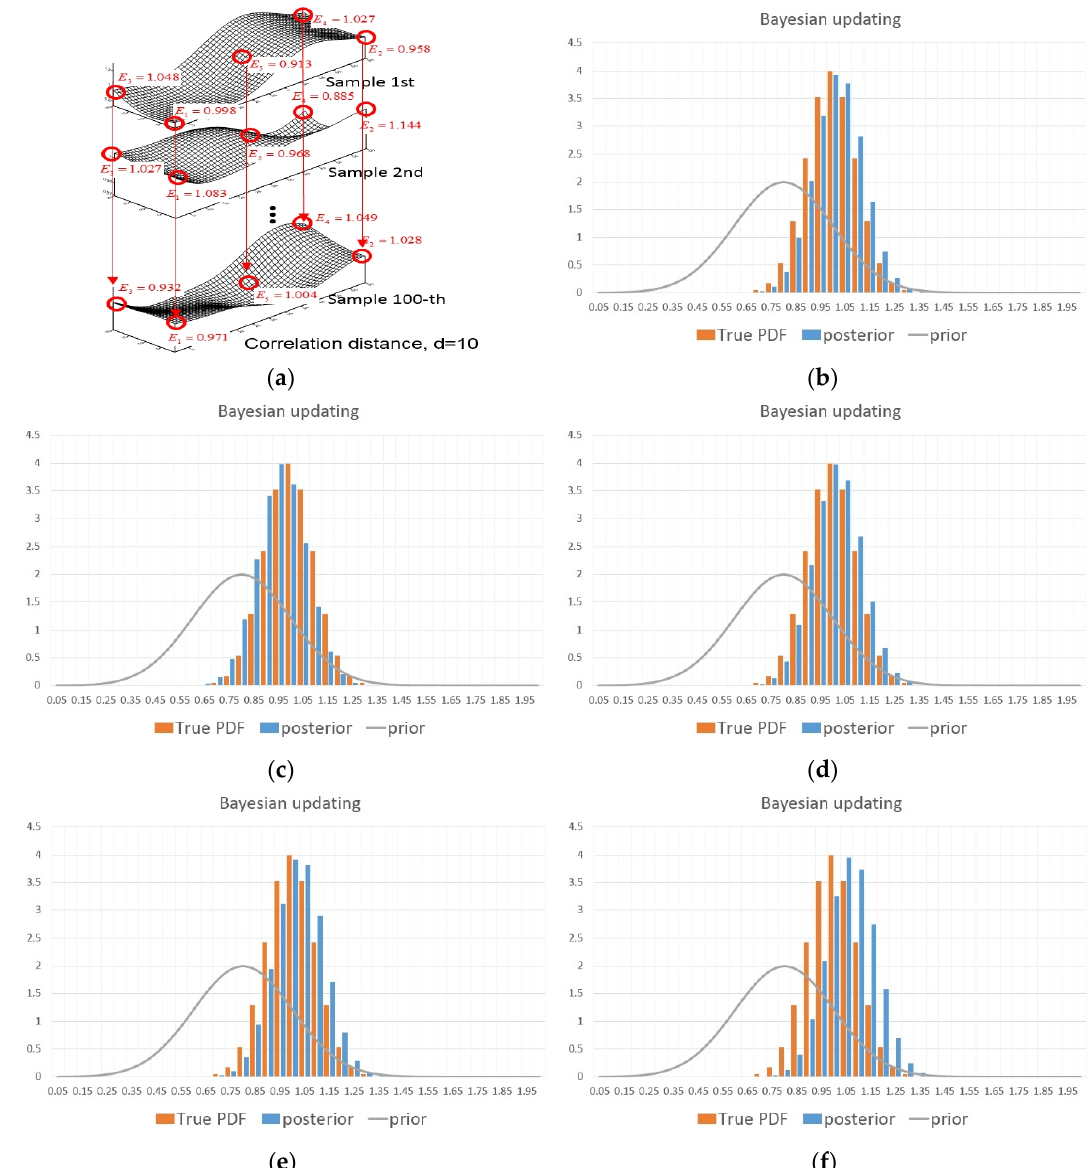
Figure 9. Bayesian updating at the stochastic field of the correlation distance d = 5.0: ( a ) How to perform Bayesian updating; ( b ) Observation point 1; ( c ) Observation point 2; ( d ) Observation point 3; ( e ) Observation point 4; ( f ) Observation point 5.